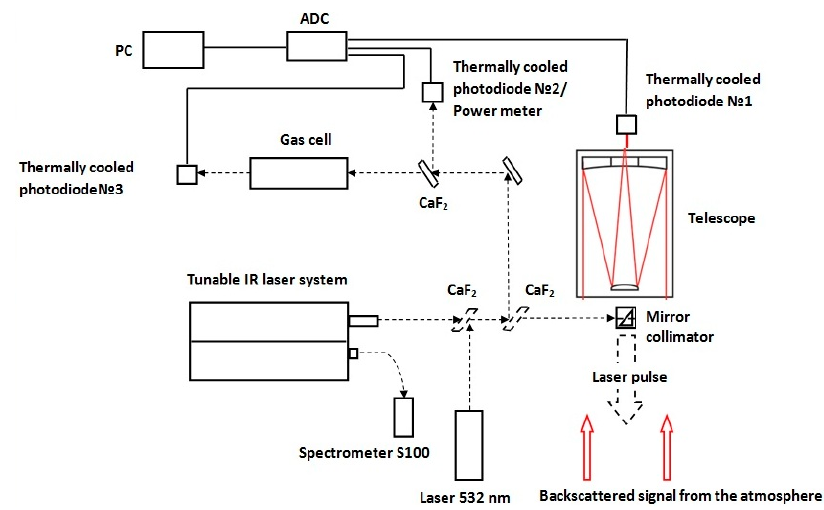
Figure 4. Calibration scheme of the IR OPO lidar system.